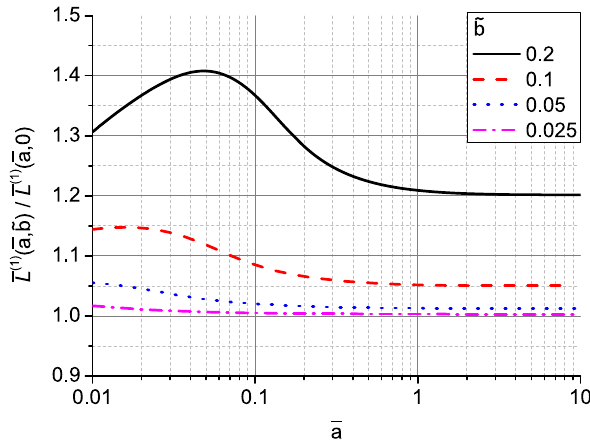
Fig. 4 ¯ L ( 1 ) ( ¯ a , ˜ b )/ ¯ L ( 1 ) ( ¯ a , 0 ) for ˜ b = 0 . 2 , 0 . 1 , 0 . 05 , 0 . 025. ¯ L ( 1 ) ( ¯ a , ˜ b